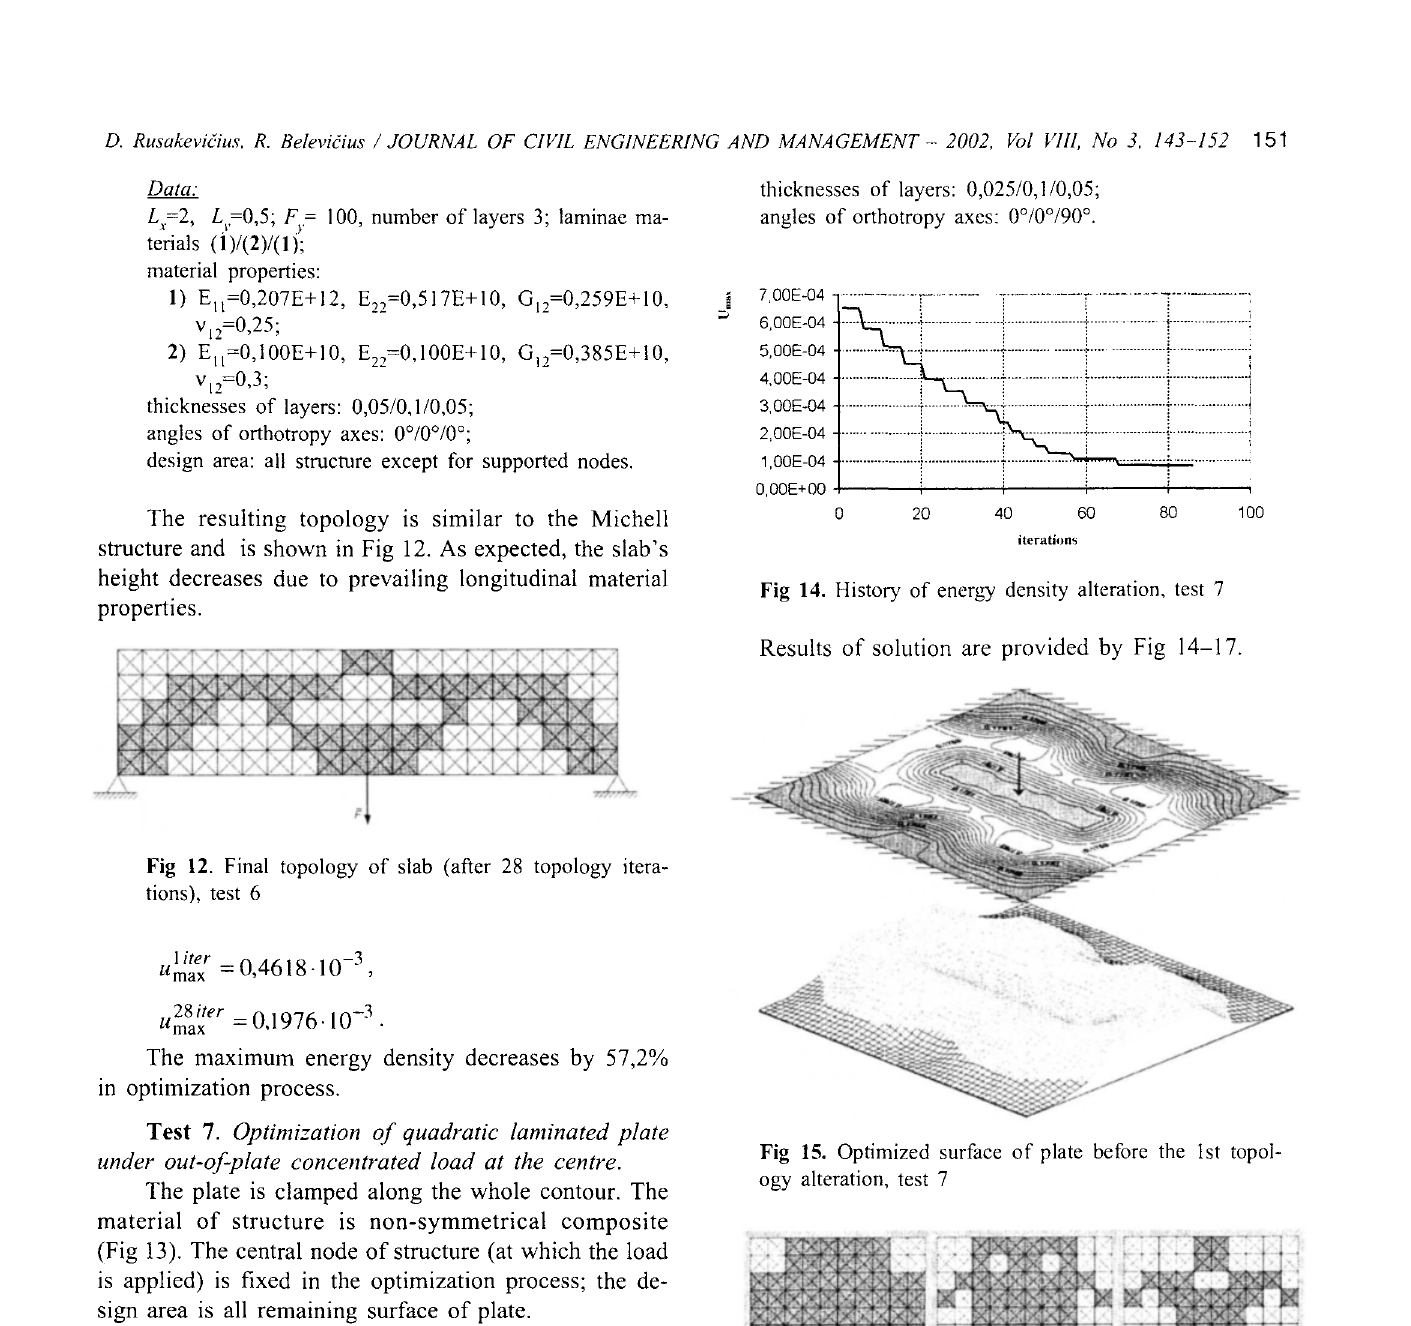
Fig 16. History of topology optimization (5, I 0, 15 topol ogy iterations), test 7